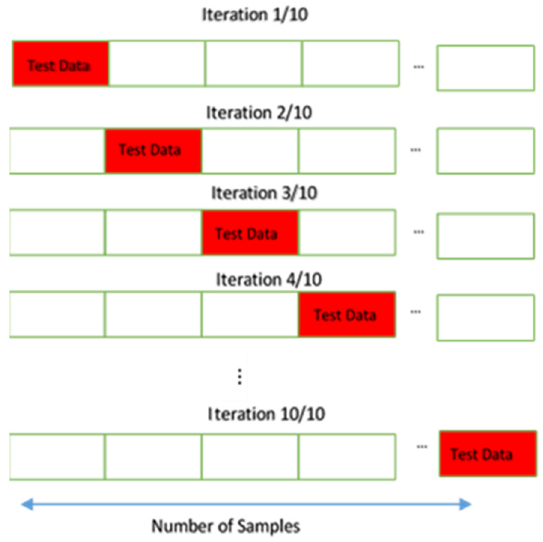
Figure 9. Description of 10-fold cross-validation.